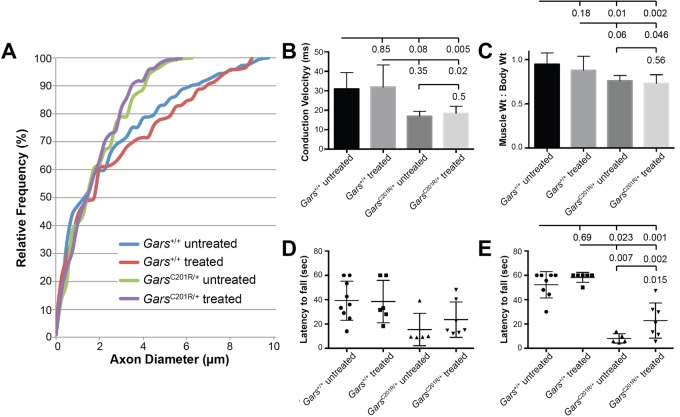
Carnitine supplementation improves motor performance, but does not alter neuropathy. (A) A cumulative histogram of femoral motor nerve axon diameters in the milder GarsC201R/+ model of CMT2D shows that supplementation with acetyl-L-carnitine does not improve axon atrophy. Both treated and untreated mutant axons are smaller than control (P<0.05, K–S test). Carnitine supplementation had no effect on control axon diameters (P=0.51), and mutant axons were also unchanged (P=0.21). (B) Nerve conduction velocity (NCV) in the sciatic nerve was also unchanged. Mutant axons with or without carntine supplementation conducted more slowly than untreated control axons (P<0.05), control NCVs were unchanged by carnitine supplementation (P=0.85), as were mutant NCVs (P=0.50). Treated controls and untreated mutants were not statistically different owing to variability in the control values and small sample size. (C) Muscle weight:body weight ratio indicated atrophy in mutant triceps surea with or without carntine supplementation (P<0.05, WT treated versus mutant untreated, P=0.06). The control weights were unchanged by carnitine supplementation (P=0.18), as were the mutants (P=0.56). Error bars represent standard deviation from the mean. (D,E) Supplementation with acetyl-L-carnitine did improve motor performance in the wire hang test of grip strength and endurance. Results are shown at the beginning of treatment (3.5 weeks of age, D), and at 7.5 weeks of age (E). Although still worse than control (P<0.01), the treated GarsC201R/+ mice did perform better than untreated mutant mice (P=0.015). N=6 WT treated and N=7 untreated; N=9 GarsC201R/+ treated and N=5 untreated. All measures at 9 weeks of age except wire hang, which was performed at 3.5 and 7.5 weeks of age.